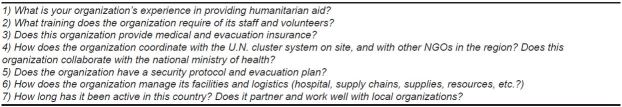
Questions to ask to determine whether or not an organization is well-prepared for a humanitarian response.